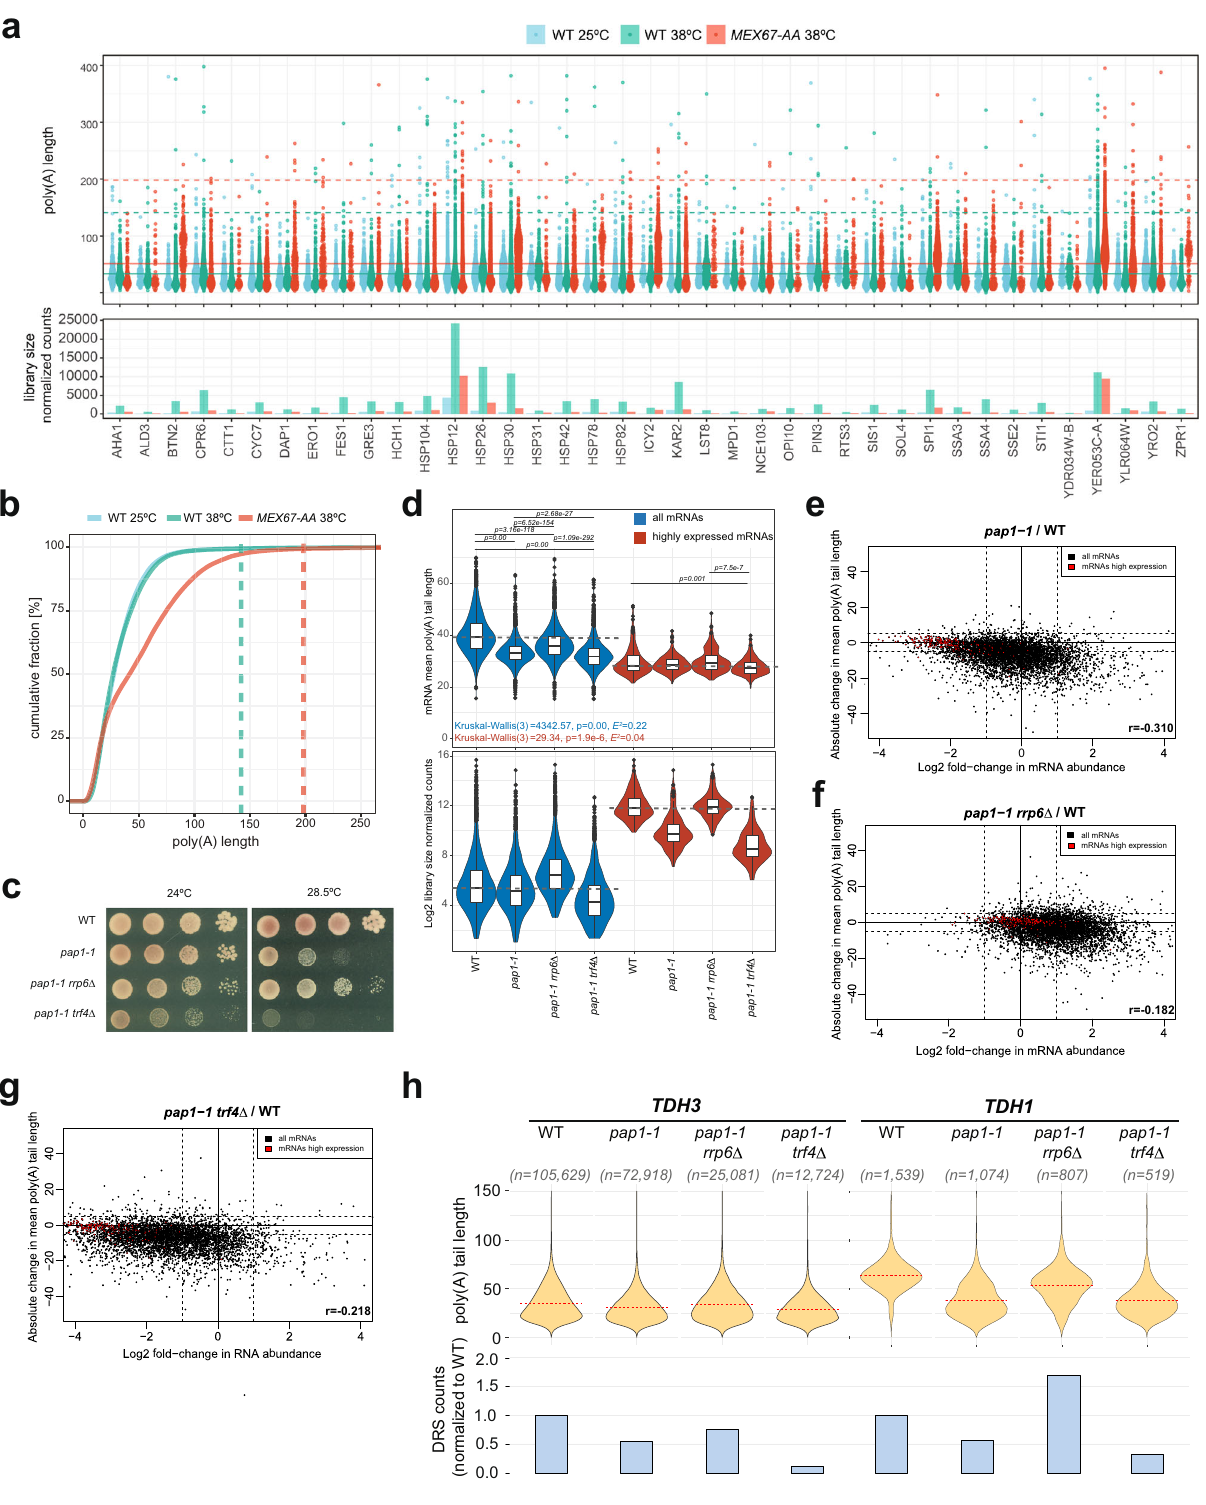
This recapitulated the known functions of the exosome and TRAMP4 in ncRNA degradation and strongly suggested that TRAMP4/5 produce poly(A) tails comparable in length to mRNAs. The deletion of RRP6 or its cofactors TRF4 or TRF5 did not affect the abundance of protein-coding genes. However, poly(A) tails were elongated by an average of 3.4 and 4 As in rrp6 Δ and trf5 Δ cells, respectively, remaining on average unaltered in trf4